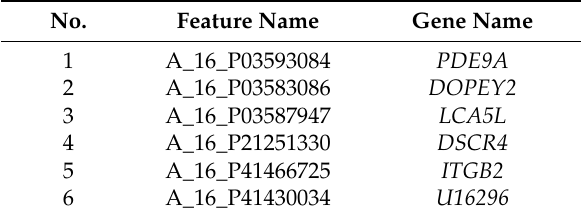
Table 3. Detailed analyzed optimal features in Section